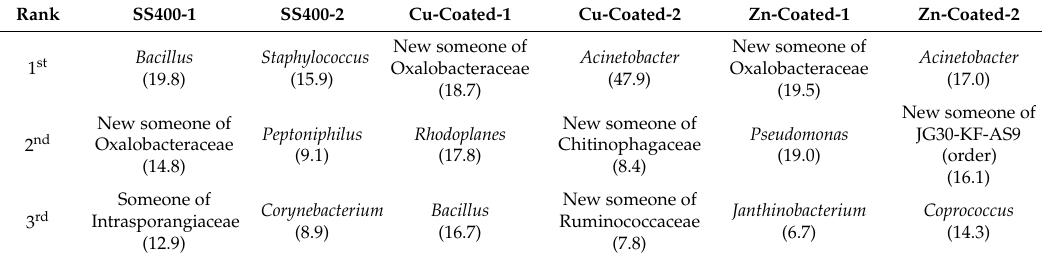
Table 1. Abundant genera of the outdoor-exposed coupons. Each column indicates the assigned genus name and percentage occupancy in parentheses. The numbers in brackets indicate the occupancy of each genus (%).